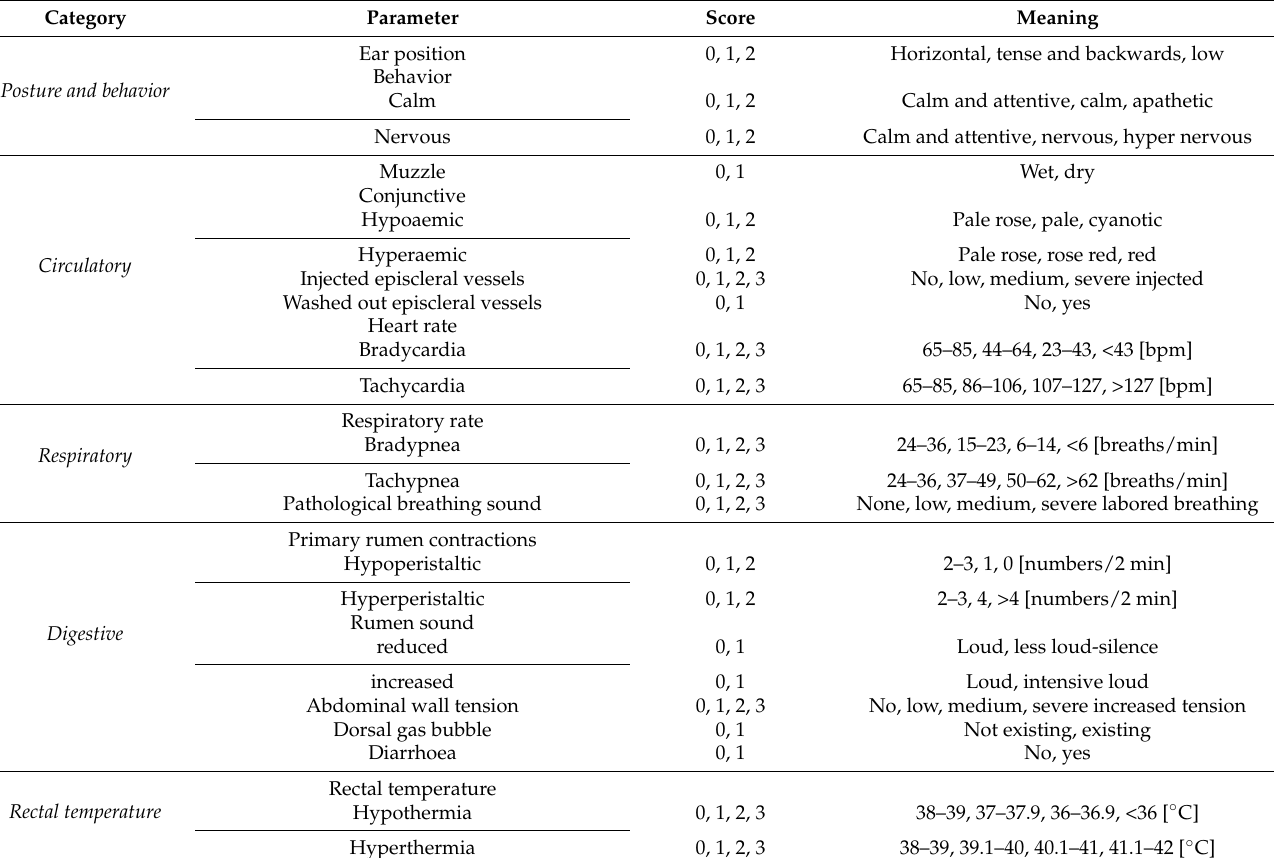
Table A1. Definition of cumulative clinical score. The physiological level has a score of 0. Clinical findings were assigned to five different categories. The lines below parameters indicate that only the parameter above or below adds to the cumulative score. A maximum of 31 points could be reached.